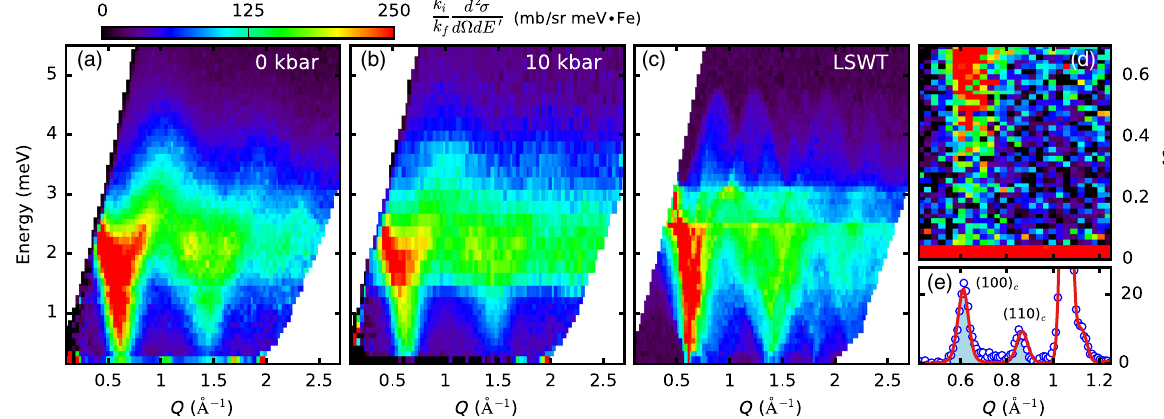
FIG. 7. (a),(b) Powder-averaged inelastic neutron scattering cross section for FeSc 2 S 4 measured at 1.6 K and 0 kbar (a) and 10 kbar (b). The cross section is placed into absolute units by calibrating against the integrated intensity from structural Bragg reflections. (c) Calculated powder-averaged neutron scattering intensity for spin waves in the collinear magnetic structure shown in Figs. 5(b) and 5(c). (d) Low-energy inelastic neutron scattering measured on CNCS. In (e) the elastic scattering is shown with magnetic diffraction peaks highlighted in light blue. Inelastic intensity is conspicuously absent near the ð 110 Þ cubic